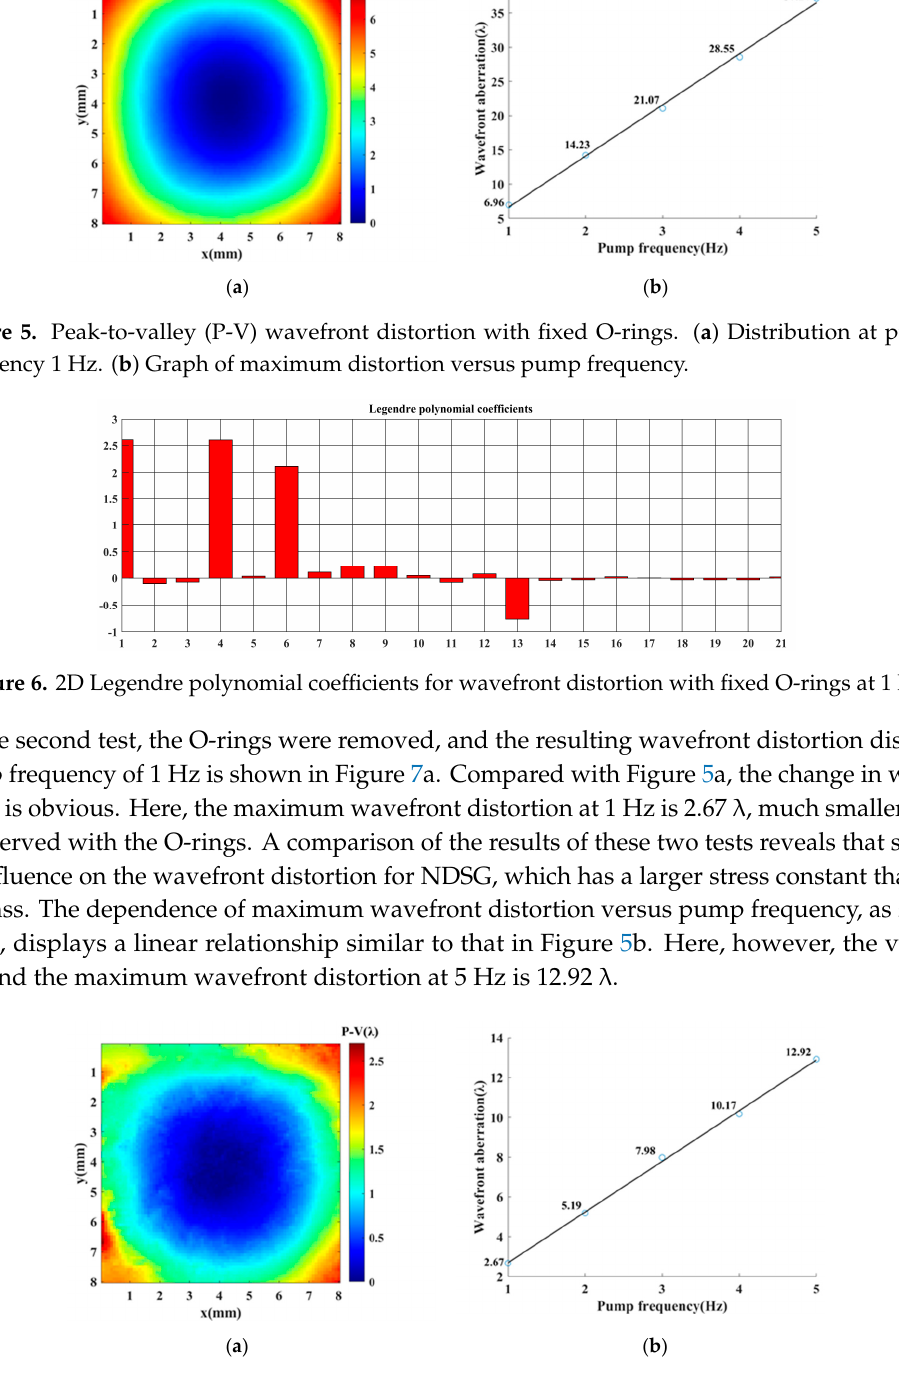
Figure 7. Peak-to-valley (P-V) wavefront distortion without fixed O-rings. ( a ) Distribution at pump frequency 1 Hz. ( b ) Graph of maximum wavefront distortion versus pump frequency.